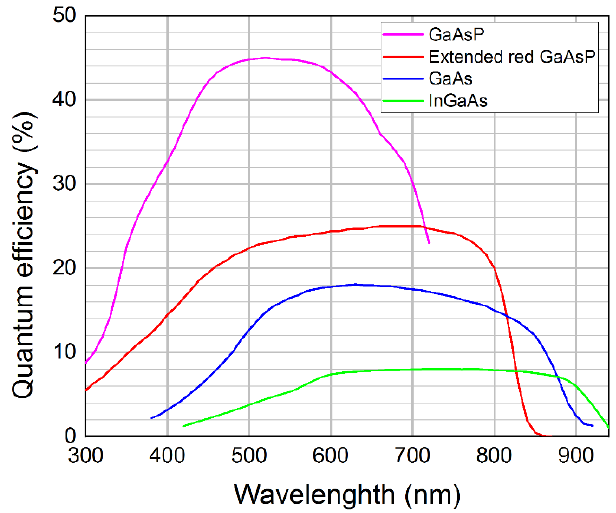
Figure 3. Spectral response of photocathodes.